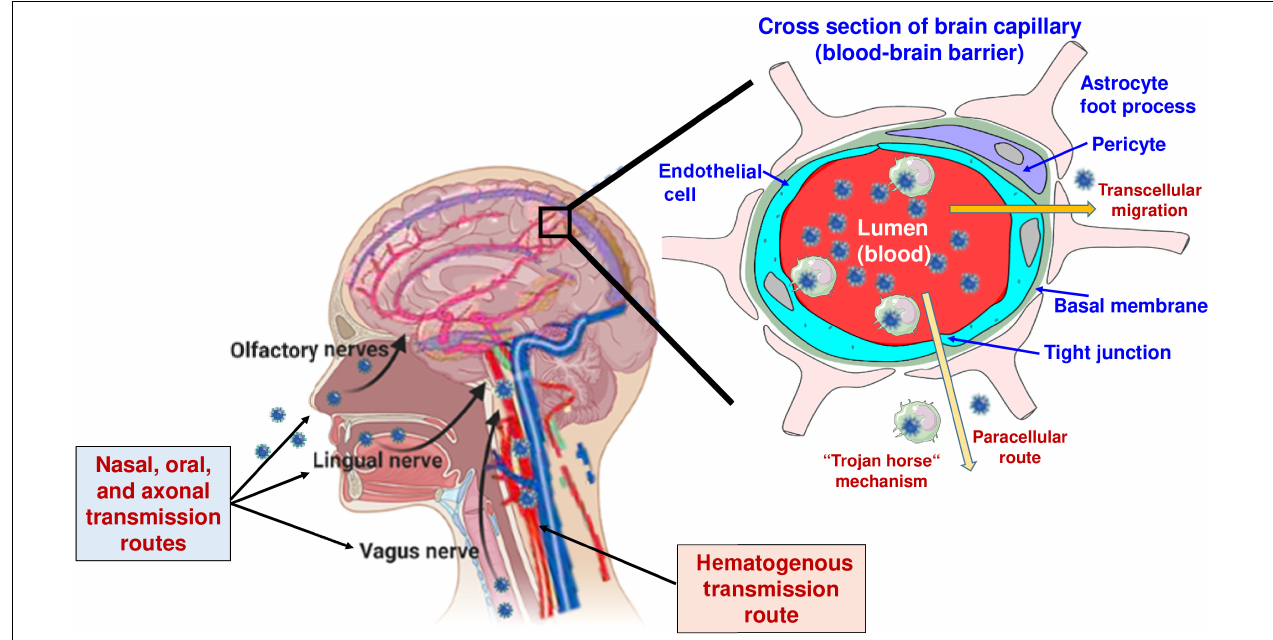
FIGURE 2 | Routes of virus invasion into the brain. In addition to the routes illustrated in the figure, viruses may enter the central nervous system (CNS) via the choroid plexus, i.e., the blood-CSF barrier (see Table 2 ). Modified from Löscher and Potschka (2005), Löscher and Friedman (2020), and Sulzer et al.